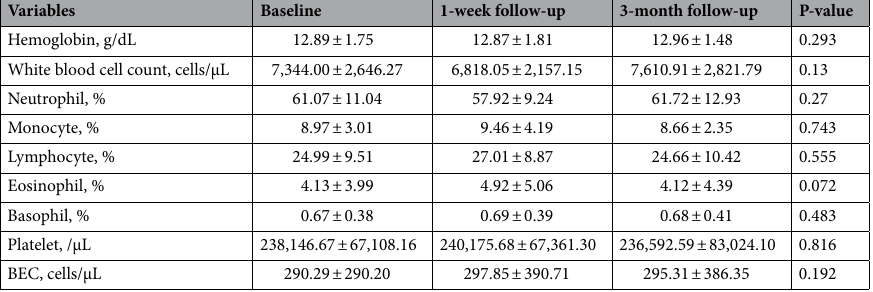
Table 2. Comparison in complete blood count results between baseline, 1-week and 3-month follow-up. Data shown as mean ± SD, ANOVA was used for comparison of 3 visits. BEC blood eosinophil count.